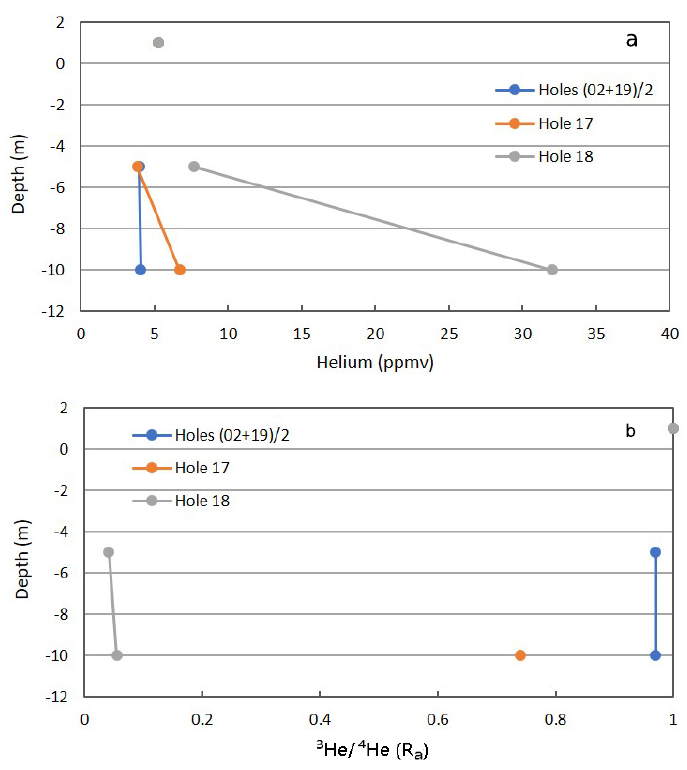
Figure 14. Helium ( a ) and 3 He/ 4 He ( b ) for combined background locations and Locations 17 and 18 in Fault Zone 2. See Figure 5 for the